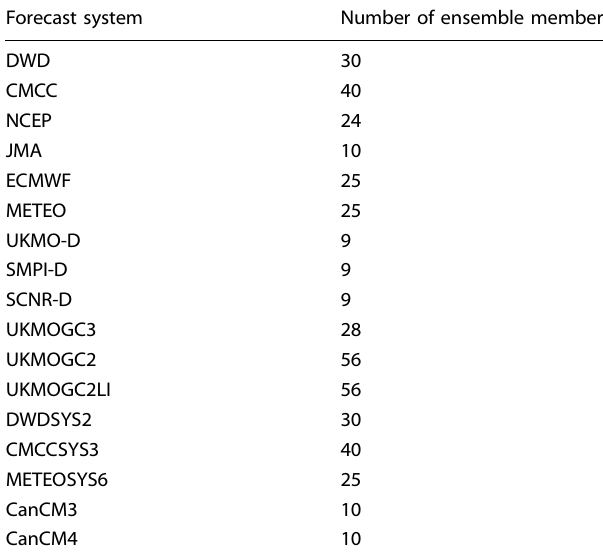
Table 2. Forecast system ensemble